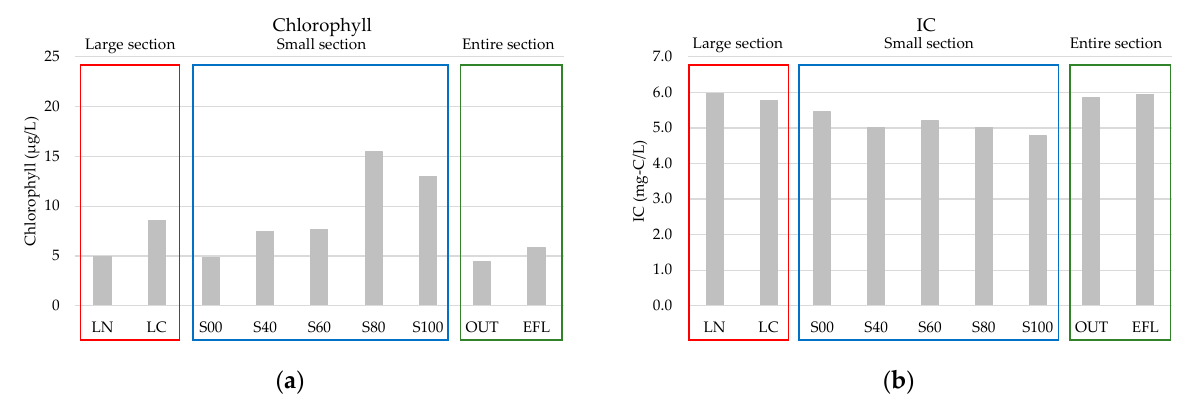
Figure 9. ( a ) Average chlorophyll level for each section; ( b ) average IC level for each section. The average pH for each section is shown in Figure 10. The sections were clustered in a relatively small area, and the water samples were collected on the same day, differing only in the presence or absence of shading. Therefore, the water quality data of each section sampled on the same day could be paired. As pH is the logarithm of the reciprocal of hydrogen ion activity, it is an ordinal scale. Therefore, the Wilcoxon signed-rank test, a non-parametric statistical hypothesis test used to compare two related samples, was performed.